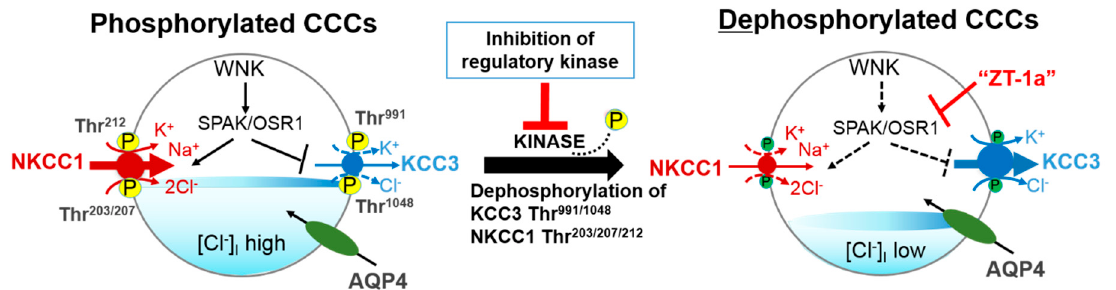
Figure 2. A novel strategy to facilitate cellular Cl − extrusion by coincident NKCC1 inhibition and KCC3 activation by inhibiting Table 1 kinases. Reversible serine-threonine phosphorylation reciprocally regulates NKCC1 and KCC3. Hypotonic low [Cl − ] i conditions or a reduction in cell volume activates the WNK-SPAK/OSR1 pathway to promote Cl − and water influx. This leads to the phosphorylation of NKCC1 and KCC3 and their activation and inhibition respectively. When [Cl − ] i becomes too high or cell volume increases, WNK-SPAK/OSR1 pathway is inhibited. The cotransporters are dephosphorylated, KCC3 is activated and facilitates [Cl − ] i and water efflux to restore ion and osmotic homeostasis. CCCs, cation-chloride cotransporters; NKCC1, K + -Cl − cotransporters; KCC3, K + -Cl − cotransporter 3; WNK, with-no-lysine kinase; SPAK, STE20/SPS1-related proline/alanine rich kinase; OSR1, oxidative stress response kinase; AQP4, aquaporin 4; ZT-1a, specific SPAK inhibitor. Part of figure elements were adapted from Salihu et al. [85].